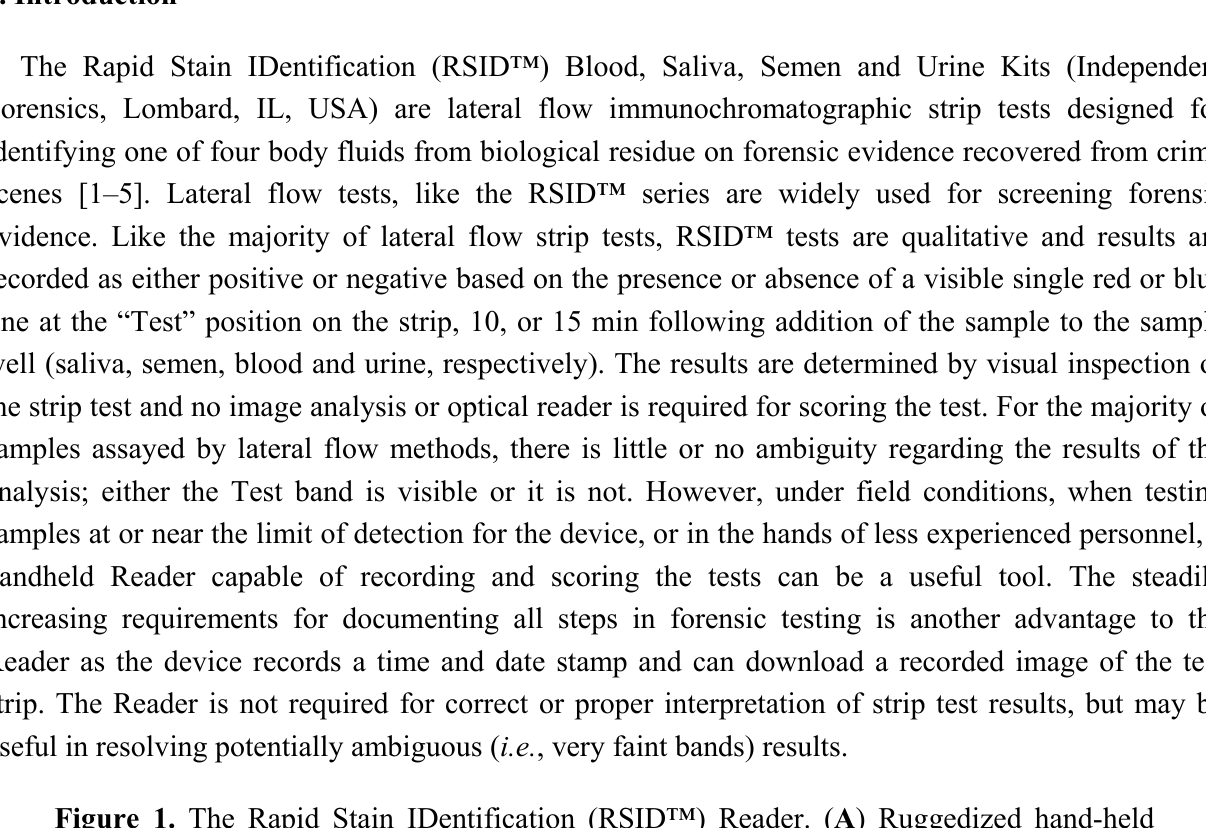
Figure 1. The Rapid Stain IDentification (RSID™) Reader. ( A ) Ruggedized hand-held RSID™ Reader unit with touch screen. Cassettes are inserted into the slot on the upper right hand side, observation window facing down, cassette name first; ( B ) Screen capture image of the downloaded electronic data from Reader; sample name, time, date and results of individual tests are recorded by the software and shown in a spread sheet